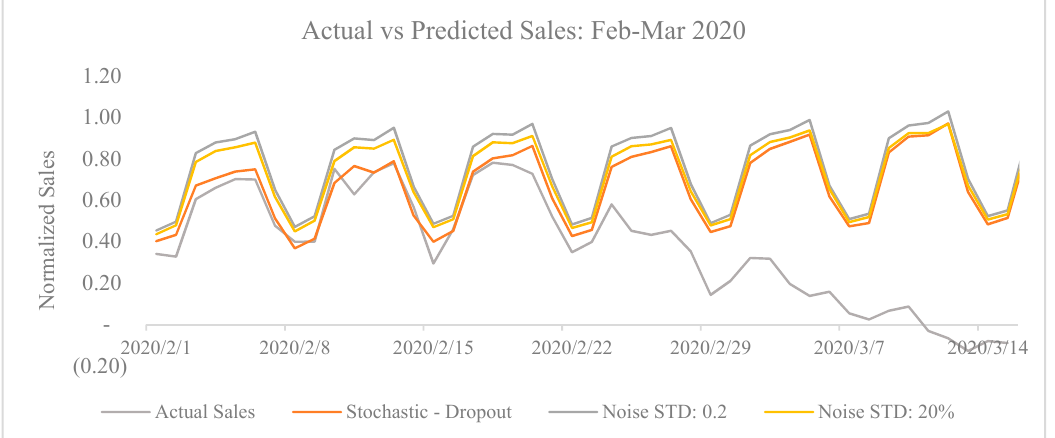
Figure 6. Impact of corona virus outbreak on sales. Both the actual sales and model predicted sales in absence of corona virus are shown. Table 2. Impact of corona virus on sales.